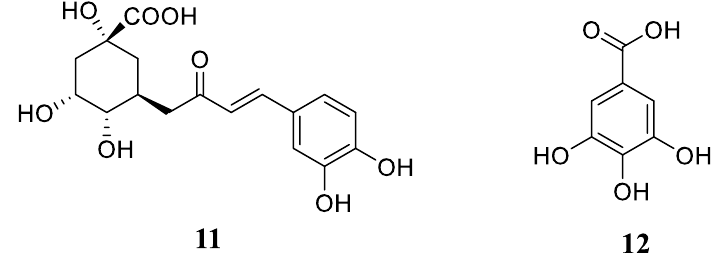
Figure 4. Chemical structures of chlorogenic acid ( 11 ) and gallic acid ( 12 ) .